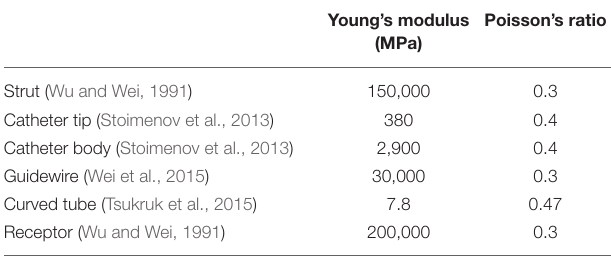
TABLE 1 | Properties of the materials in the experimental finite element (FE) model.